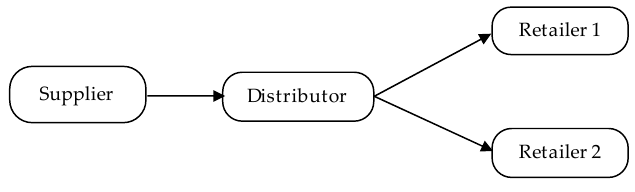
Figure 1. Three-stage two-echelon supply chain.